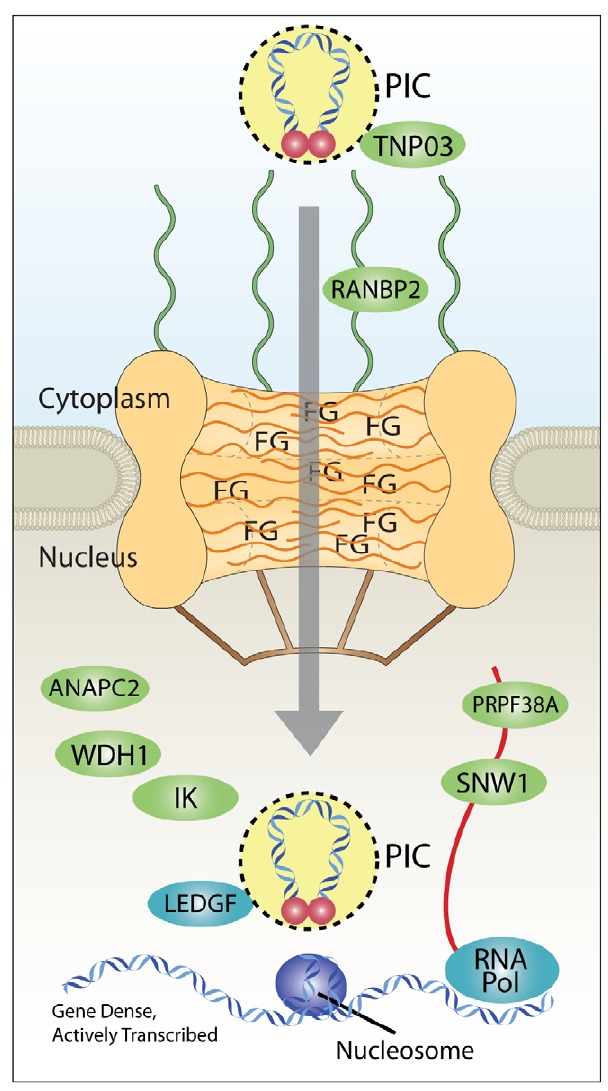
Figure 9. Model for coupling of nuclear import and integration targeting. Interaction with Transportin-3 and RanBP2 shuttles the PIC through the nuclear pore and toward gene dense regions favored for HIV integration. Interactions with additional factors in the nucleus (ANAPC2, WDH1, IK, PRPF38A, and SNW1) may also play a role in site selection upstream of the known integration cofactor Ledgf/p75, which targets integration to active transcription units. RNA Pol indicates RNA polymerase II, which is known to be required for transcriptional activity, and which promotes integration [13–15,18]. Nucleosomes are shown because target DNA is known to be wrapped in nucleosomes during the integration step [36,57–60]. PIC, preintegration complex; FG, phenylalanine-glycine repeat sequences of nuclear pore